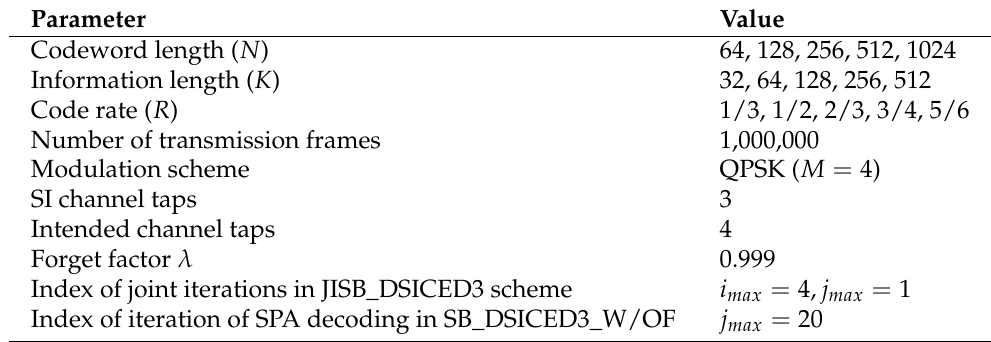
Table 2. Simulation